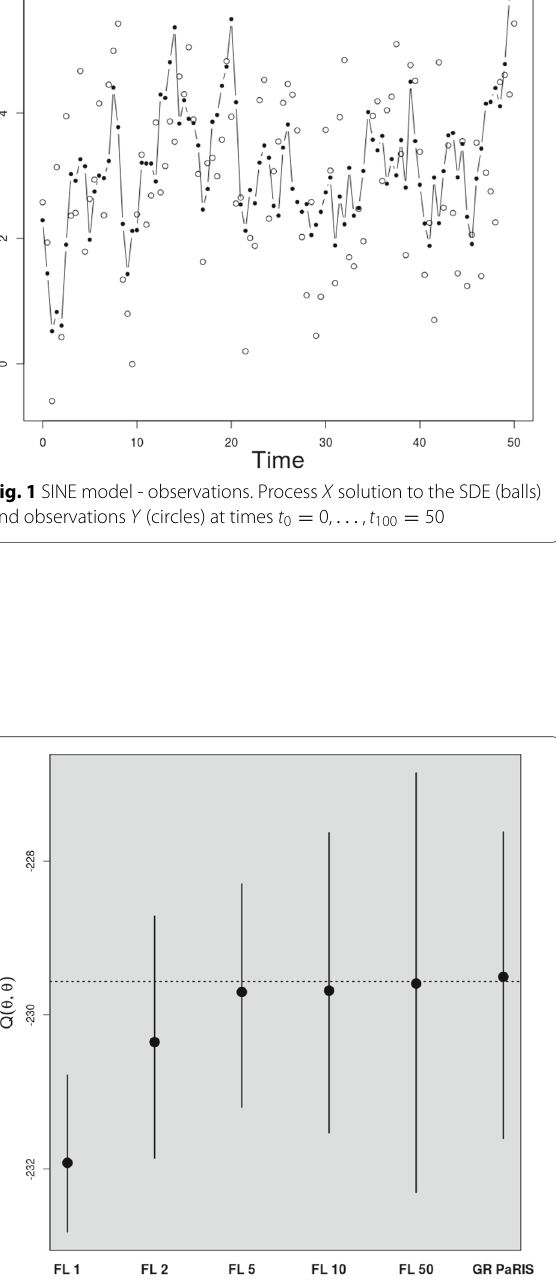
Fig. 2 SINE model - EM intermediate quantity. Estimation of the EM intermediate quantity Q (θ , θ) using the fixed-lag (FL) technique for five different lags, and the GRand PaRIS algorithm using 200 replicates. The whiskers represent the extent of the 95% central values. The dot represents the empirical mean over the 200 replicates. The dotted line shows the reference value, computed using the GRand PaRIS algorithm with N = 5000 particles